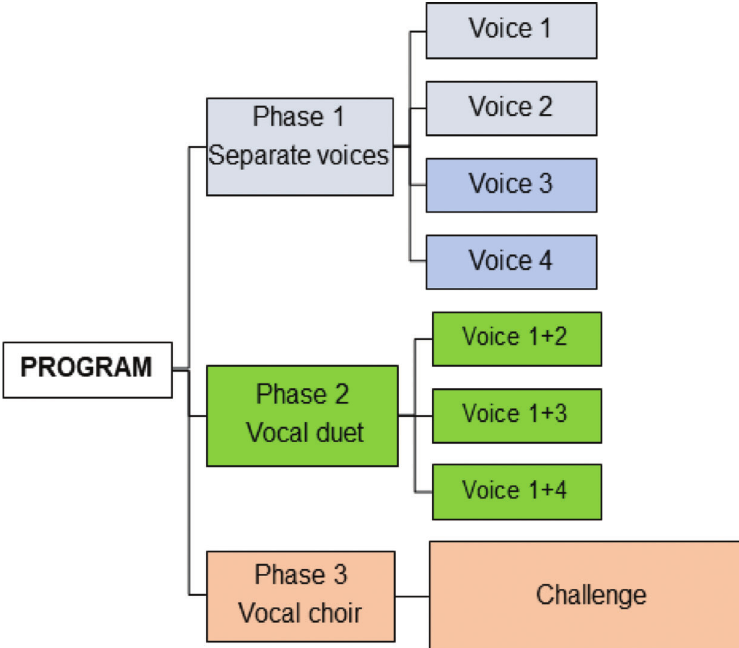
Figure 1 - Flowchart showing the use of the auditory training program with vocal